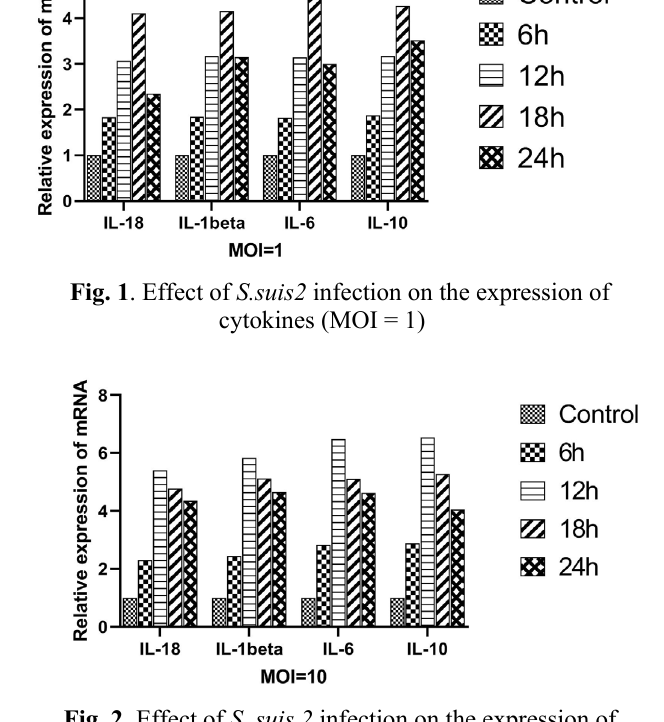
Fig. 2. Effect of S. suis 2 infection on the expression of cytokines (MOI =